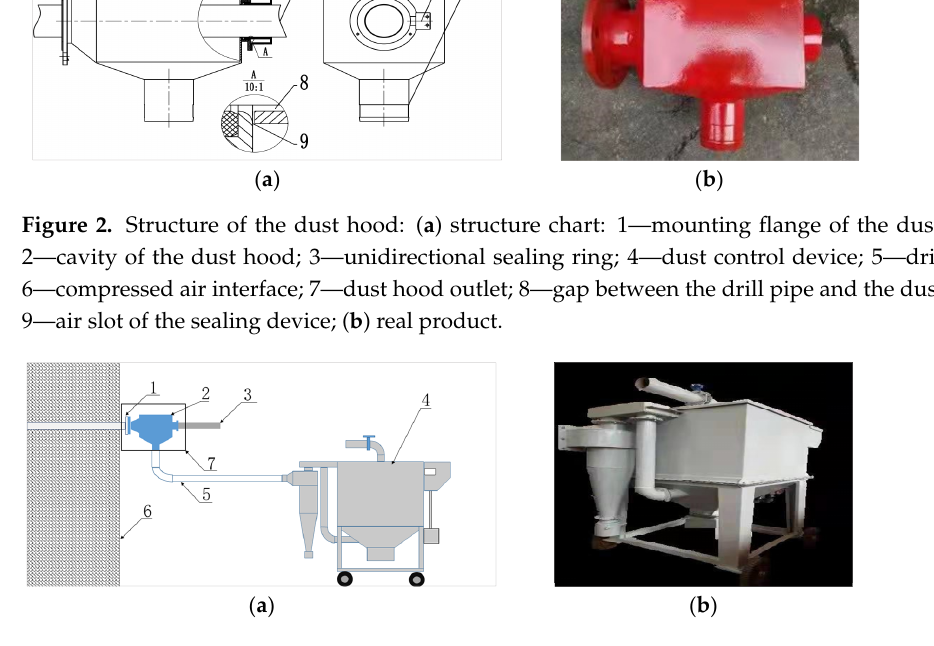
( b ) Figure 5. Dust hood testing system: ( a ) cross-section of the product: 1—screw-driven dust-generating device; 2—sealing pipeline; 3—dust hood; 4—dust control device; 5—drill pipe; 6—KJ25 interface; 7—air compressor; 8—dust collection pipe; ( b ) real product. In this product, the outer diameter of the drill pipe is 75 mm, the inner diameter of the sealing pipe is 150 mm, and the dust output from the screw-driven dust-generating device is 6 kg/min. A negative pressure value of 1.5 kPa was added to the dust-collection pipe to simulate the negative pressure generated by the dry dust collector. Part of the air pressure of the air compressor was used for drilling, and the rest was used for slag dis- charge. Preliminary investigations and tests indicated that the slag discharge pressure was normally around 0.3 MPa, so the pressure in this testing system was set to this value accordingly. Under the above testing conditions, the parameters affecting dust control of the dust hood were examined. A dust concentration test was conducted according to the test method specified in GB 5748-85 “Method for Determination of Dust in the Air of